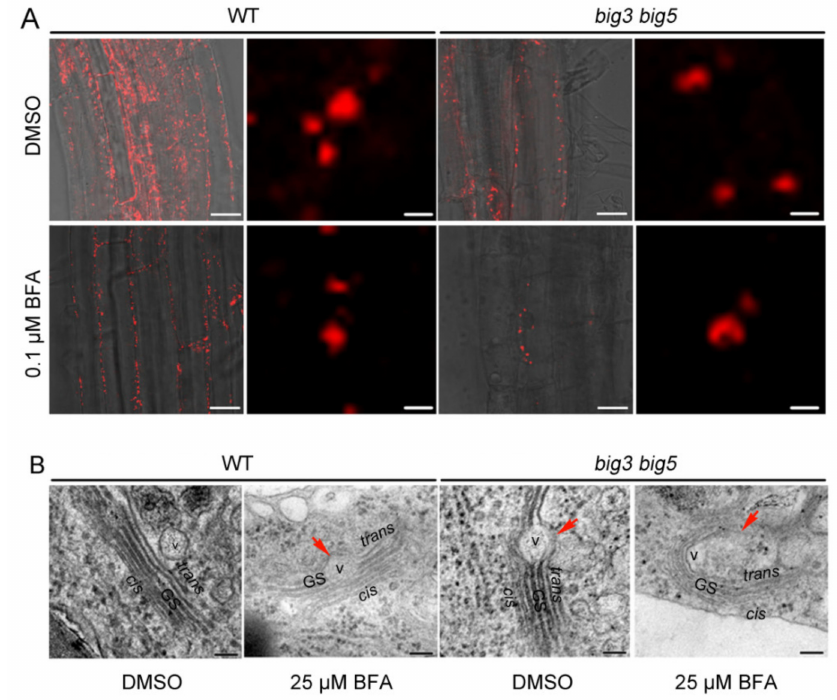
Figure 6. The Golgi structure in WT and big3 big5 with or without BFA treatment. ( A ) the WT and big3 big5 seeds expressing Golgi-RFP were germinated on 1/2 MS medium for 3 days, and then the seedlings were transferred to 1/2 MS medium containing 1/1000 DMSO and 0.1 µ M BFA for 5 days. The morphology of Golgi apparatus was observed under confocal microscopy. The right lane (Bars = 2 µ m) of each genotype is the enlarged image of the left lane (Bars = 20 µ m). ( B ) the ultrastructure of Golgi in WT and big3 big5 cultured on 1/2 MS or treated with 25 µ M BFA for 4 days. Bars = 100 nm. GS, Golgi stacks; V, vesicle; arrow heads, abnormal vesicle-like